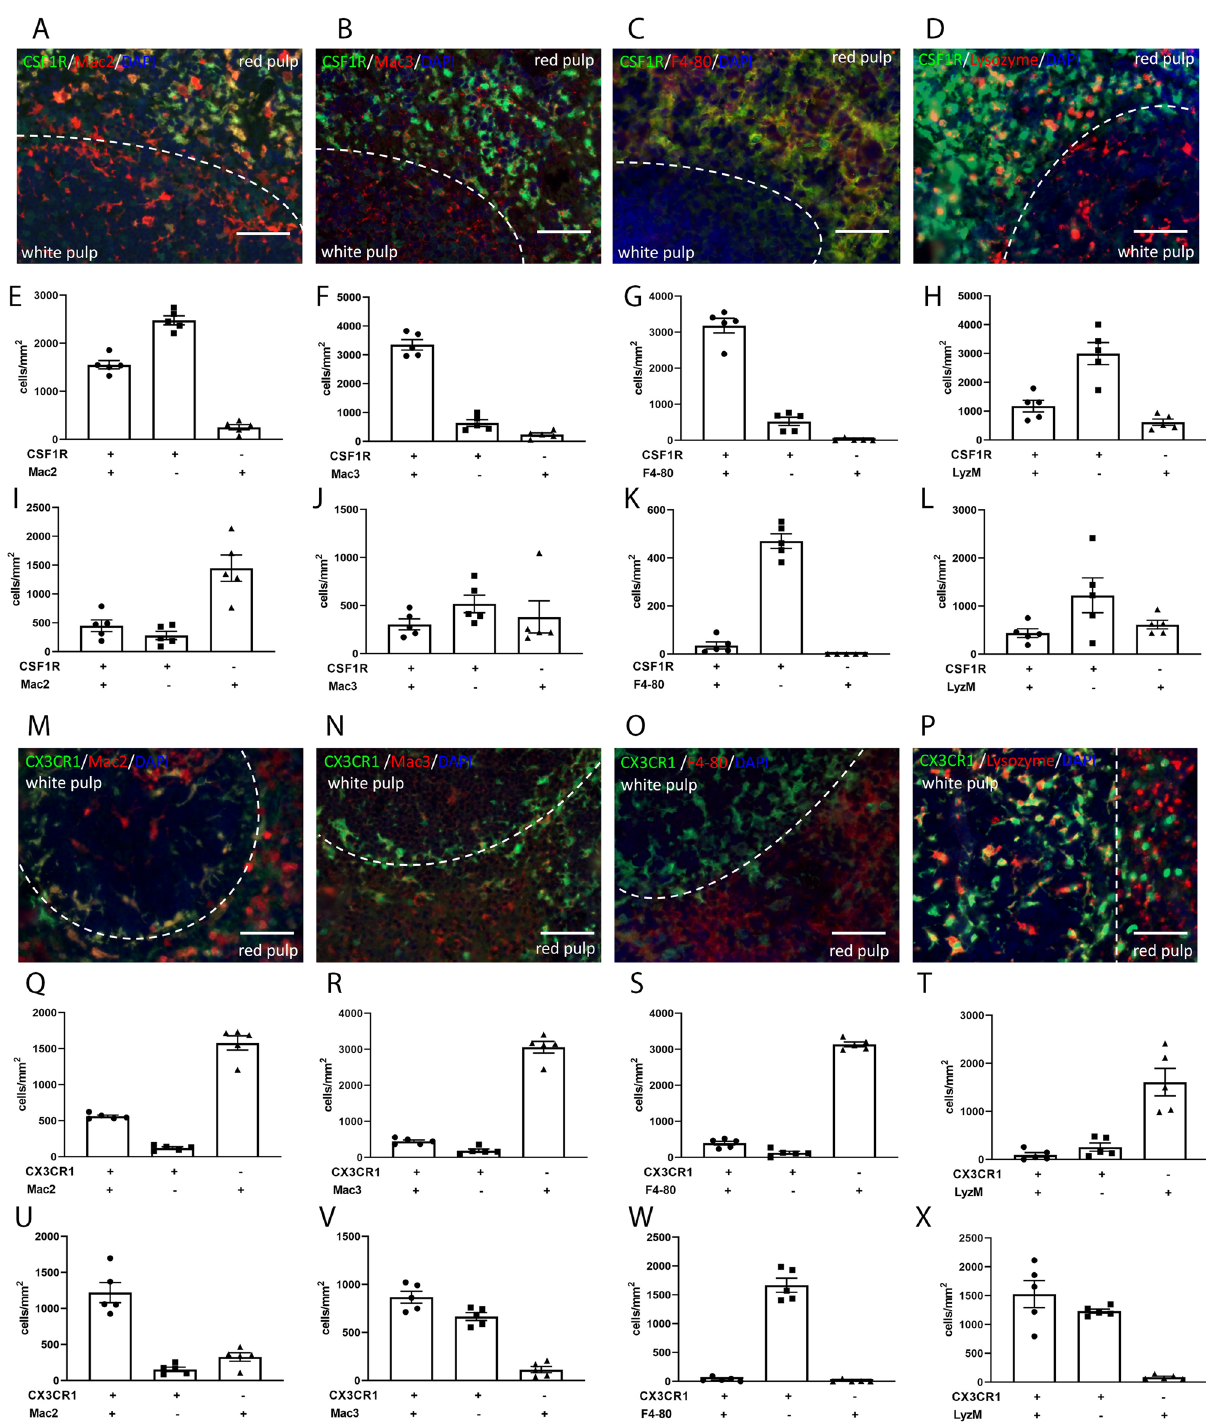
Figure 3. Use of reporter lines and antibodies to identify splenic macrophages in the red and white pulp. ( A – D ): Representative images show staining of CSFR1+ macrophages with Mac2, Mac3, F4/80 and anti-lysozyme M antibodies in the red and white pulp. The dotted line represents the marginal zone. ( E – H ) Quantitative analysis shows that abundant CSF1R+ cells are located in the red pulp of the spleen. Dual immunofluorescent staining showed that the majority of the CSF1R+ cells in the red pulp are Mac3+ (F, 83.91% ± 3.002) and F4/80+ (G, 85.77% ± 3.117) positive. In contrast, only 38.52% ± 1.449 of CSF1R+ cells are labeled with Mac2 ( E ) and 28.90% ± 5.995 are Lysozyme M+ (stained with anti-lysozyme antibody, clone EPR2994(2)) ( H ). I-L: CSF1R/Mac2 ( I ), CSF1R/ Mac3 (J), CSF1R/F4-80 ( K ) and CSF1R/Lysozyme ( L ) staining shows a low density of CSF1R+ cells in the white pulp. ( M – P ) Representative images show staining of CX3CR1+ macrophages with Mac2, Mac3, F4/80 and anti-lysozyme M antibodies in the red and white pulp. The dotted line represents the marginal zone. Q-T: Quantitative analysis shows that most of the cells stained with macrophage antibodies in the red pulp are CX3CR1 negative. U-X: Abundant CX3CR1+ cells are located in the white pulp. Mac2 labels most of the CX3CR1+ cells (88.62% ± 2.087, U), whereas Mac3 (V) and Lysozyme M (X) label more than half of the CX3CR1+ cells. F4/80 does not stain any CSF1R+ (K), or CX3CR1+ (W) cells in the white pulp of the spleen. Scale bar: 50